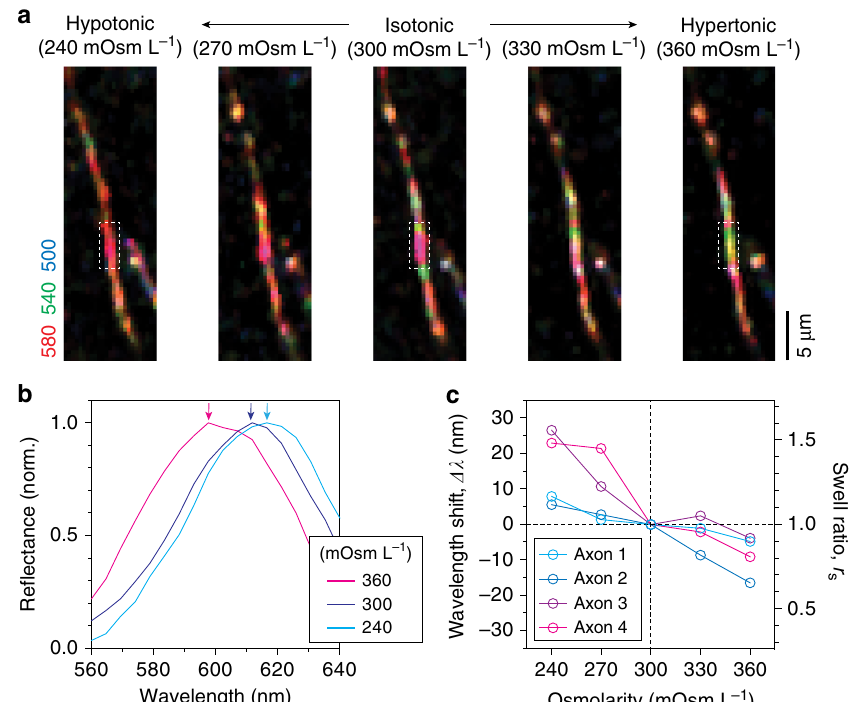
Fig. 5 Nanoscale sensing of myelin swelling under osmotic challenge. a SpeRe on the myelinated axon in the freshly sliced brain cortex under osmotic challenge. The osmotic pressure changed from 240 to 360 mOsmL − 1 . b Representative re fl ectance spectra from the demarcated regions in a . Arrows in corresponding colors indicate the peaks. c Quanti fi cation of spectral shift in response to changes in osmotic pressure ( n = 4